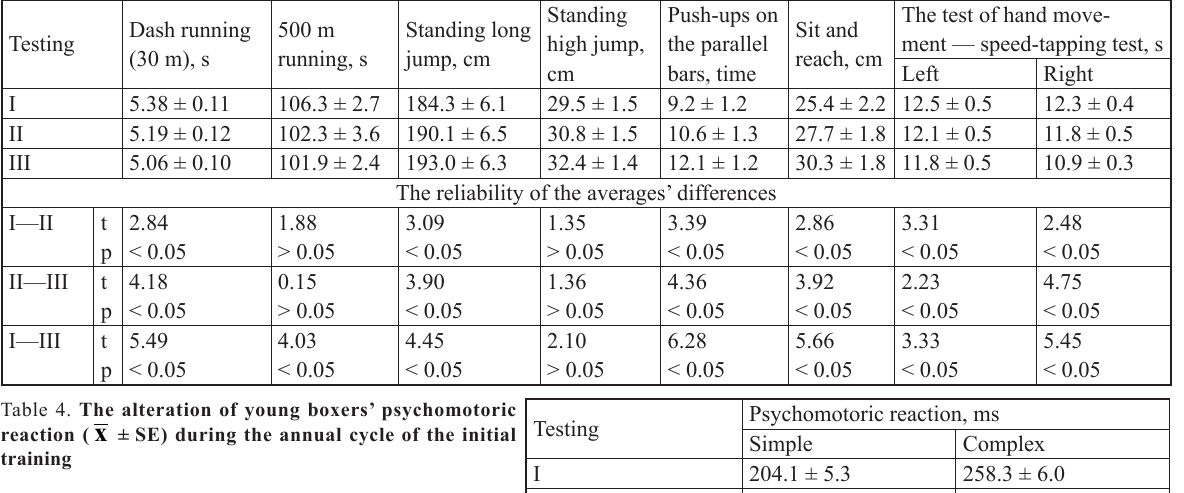
Table 4. The alteration of young boxers’ psychomotoric reaction ( x ± SE) during the annual cycle of the initial training